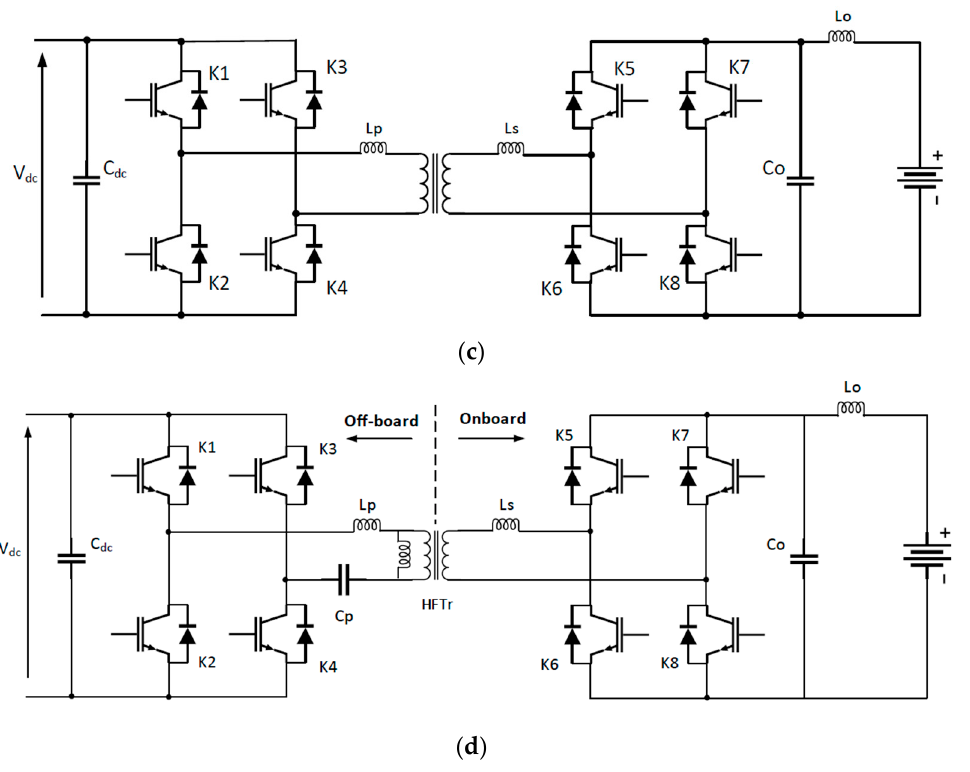
Figure 9. The electrical schematics of the most used dc-dc power conversion stage in EV chargers with V2X technology: ( a ) non-isolate bidirectional half-bridge dc-dc power converter; ( b ) Bidirectional interleave dc-dc power converter; ( c ) Isolated bidirectional dual-active bridge dc-dc power converter; ( d ) Inductive bidirectional dual-active bridge dc-dc power converter.